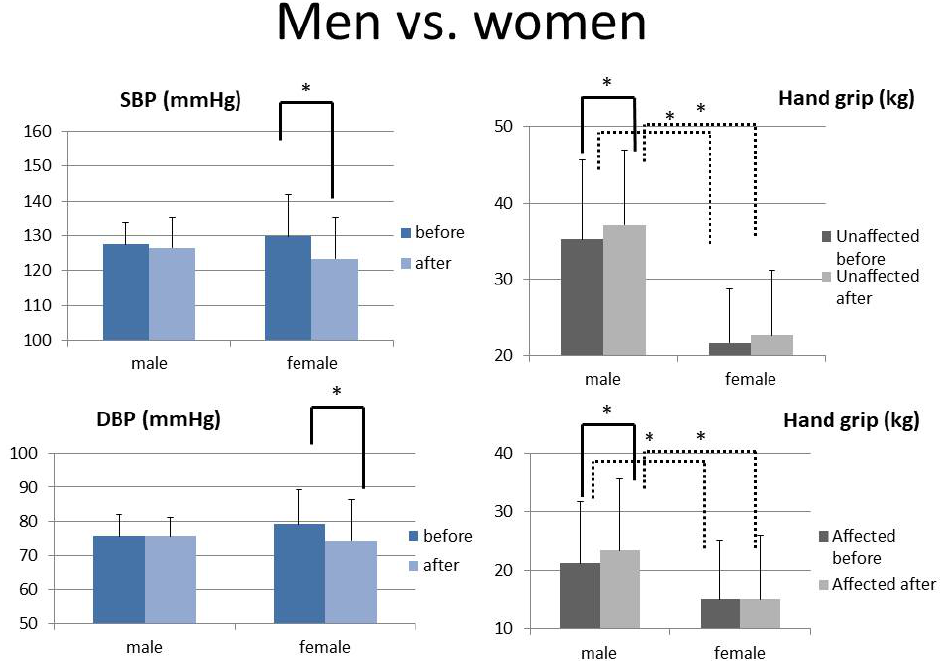
Figure 3. The pre- and post-intervention levels of SBP, DBP, and handgrip of the unaffected and affected hands between male and female groups (paired t -test is shown with a solid line and independent t -test with a dotted line) *: p < 0.05. (Bars represent the standard deviation).